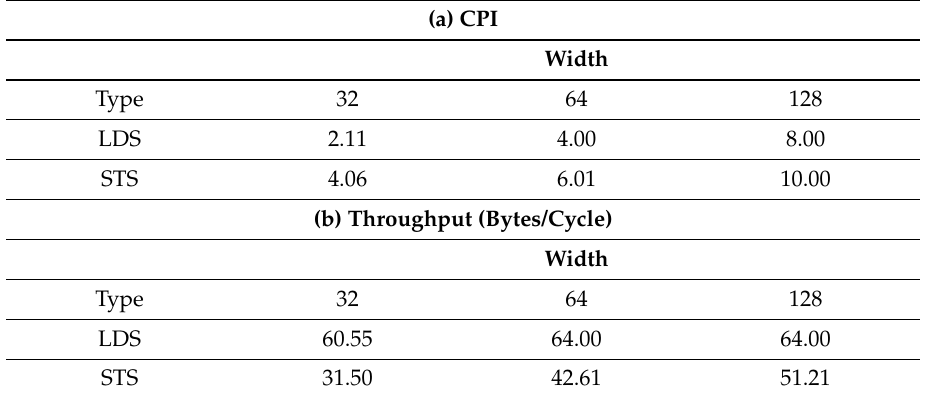
Table 1. LoaD from Shared memory (LDS) and STore to Shared memory (STS) instructions